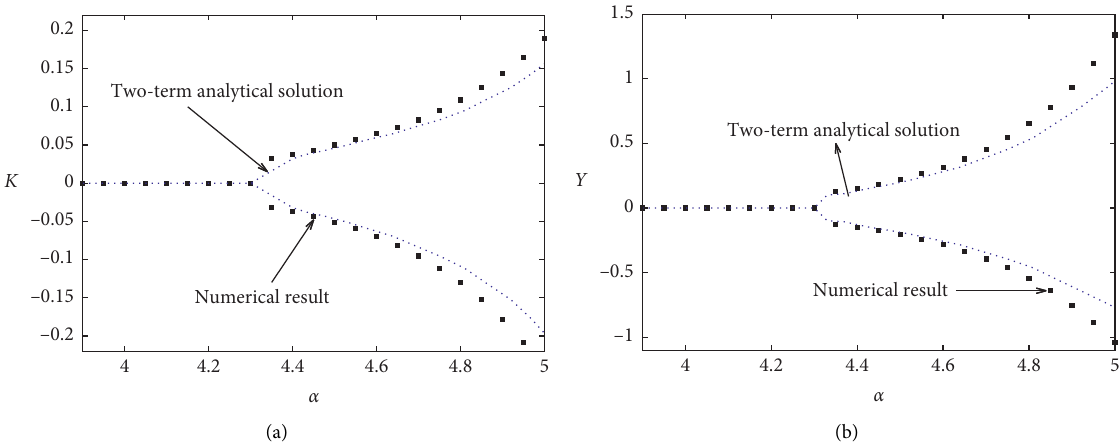
Figure 9: (a, b) The bifurcation diagrams for the capital Y and gross product K against the adjustment coefficient for the production market α . The two-term solutions and numerical results are